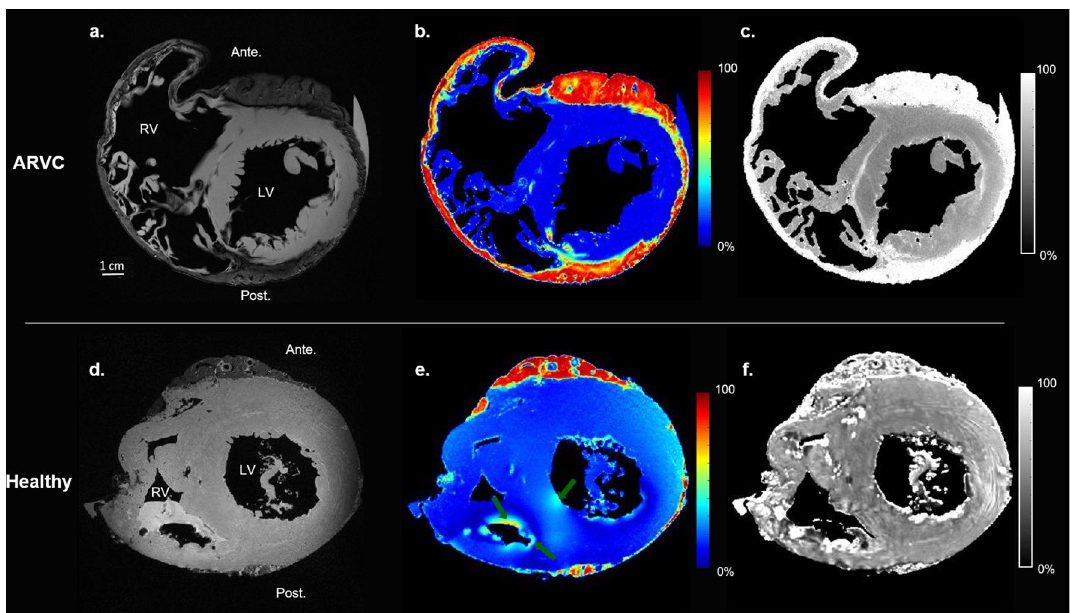
Figure 3. Short axis view of the ARVC and healthy hearts. Short axis view of the ARVC heart (top) and the healthy heart (bottom). An IDEAL first echo ( a , d ), proton density fat fraction map (PDFF) ( b , e ) and MTR contrast ( c , f ) of both the hearts respectively are shown. The healthy heart presents some residual formalin in the RV, leading to some susceptibility artefacts on the PDFF (dark green